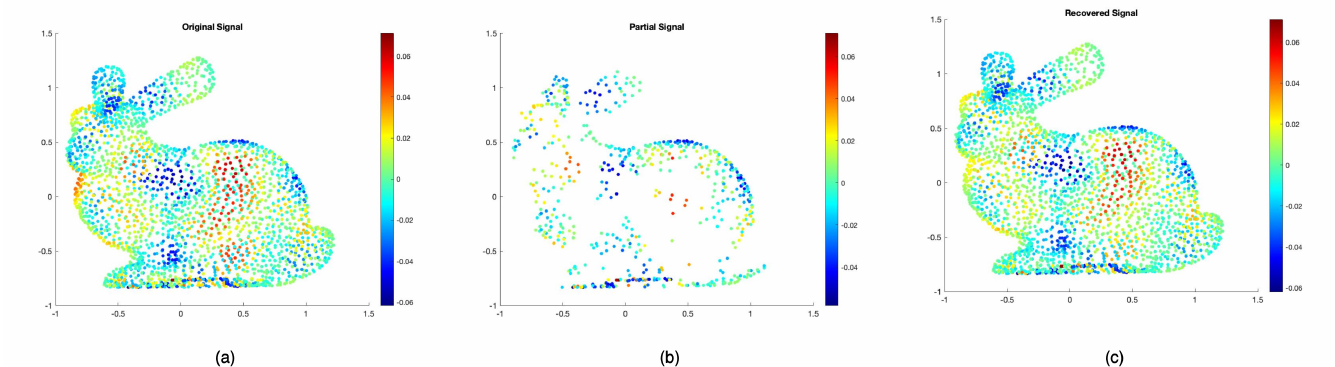
Figure 4. Toy example of our framework on GSP bunny (N = 2503). ( a ) Band-limited random signal in [0, 1] with noise, ( b ) sampled signal at m = 600 locations out of 2503, ( c ) recovered signal using our method with k =